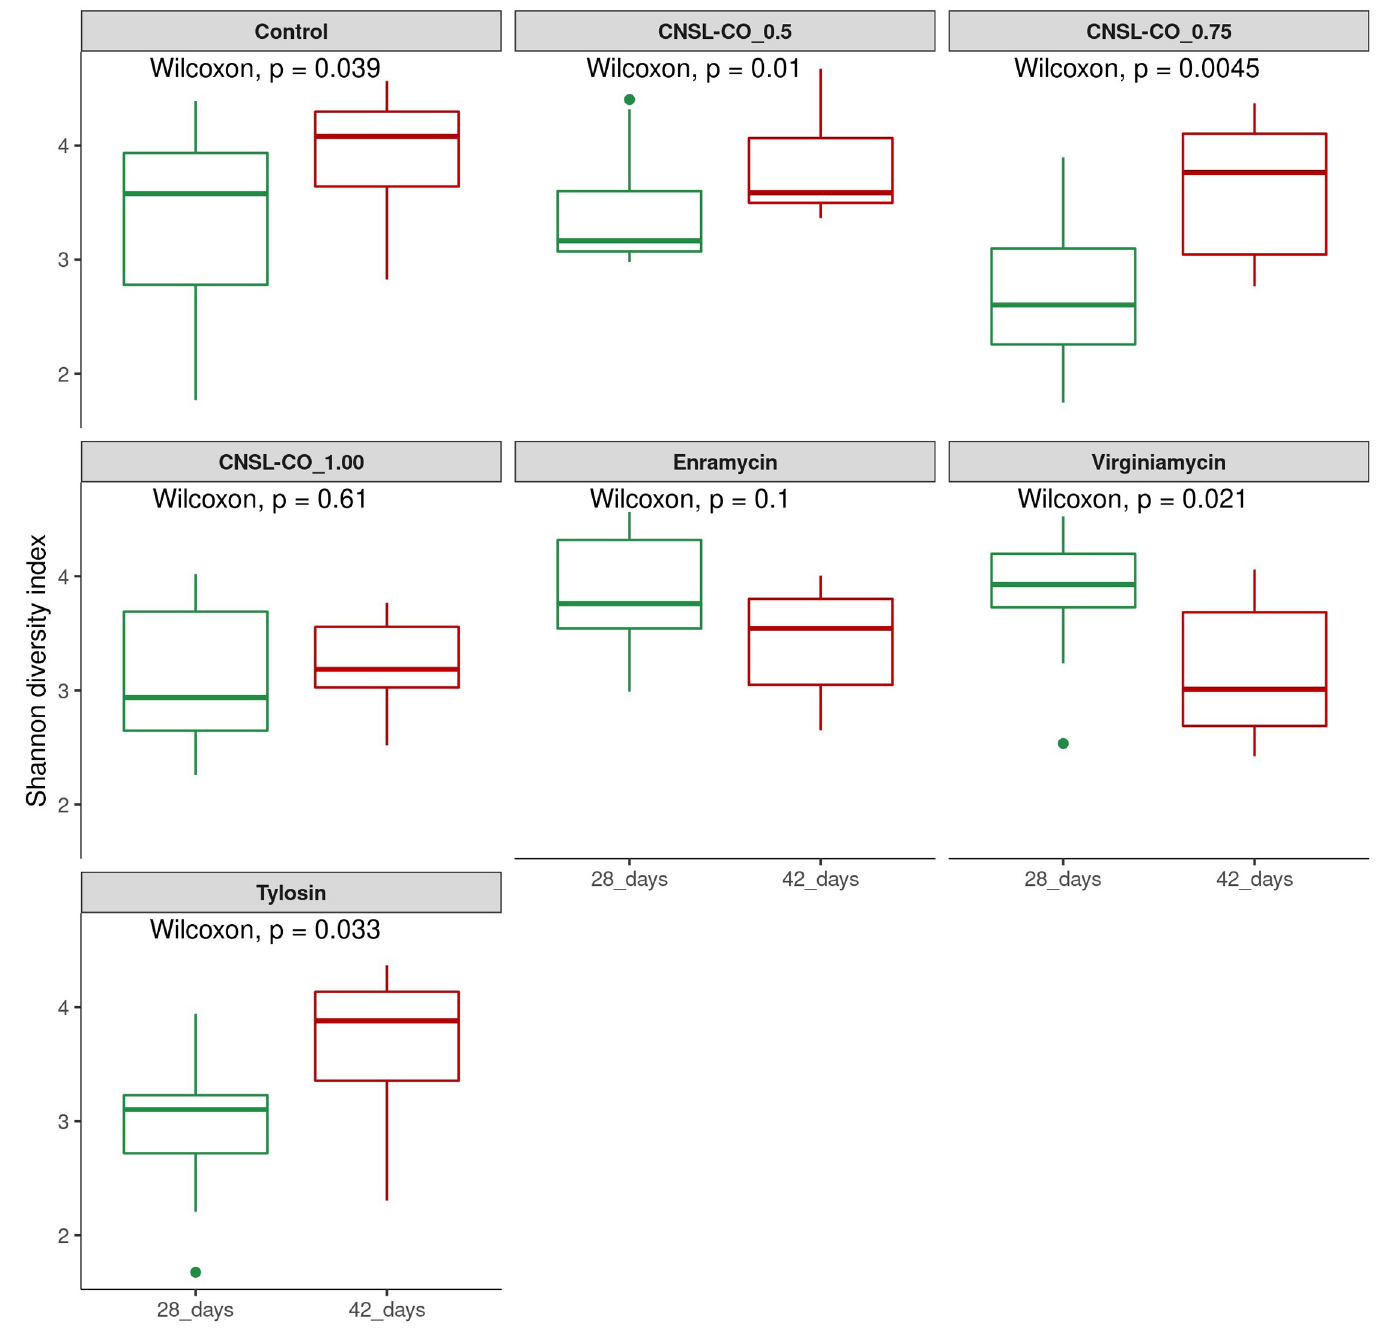
Fig 2. Comparison of alpha diversity for each additive between time points using Shannon index of broilers cecum samples at 28 and 42 d of trial. The study tested seven feed additives: enramycin (8 ppm), virginiamycin (16.5 ppm), tylosin (55 ppm), CNSL-castor oil (CNSL-CO) at different doses (0.5, 0.75, and 1.00 kg/t), and the control diet (without